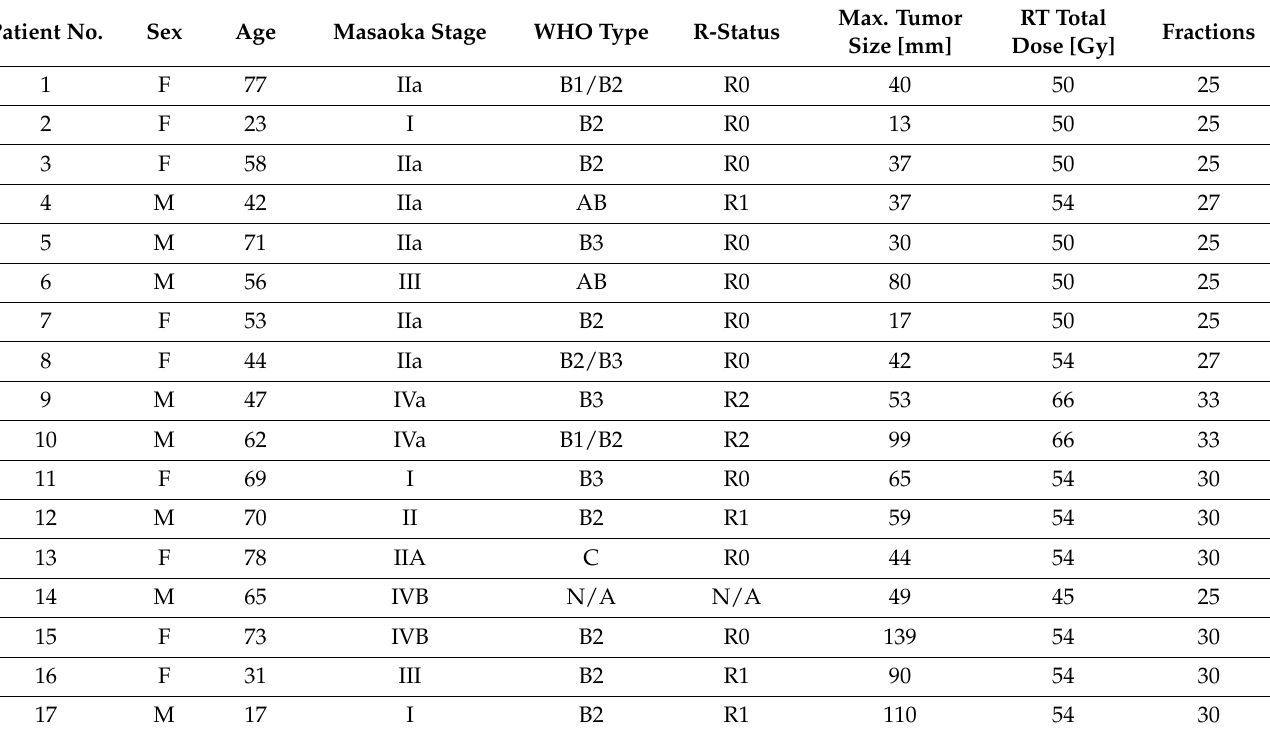
Table 3. Clinical patient